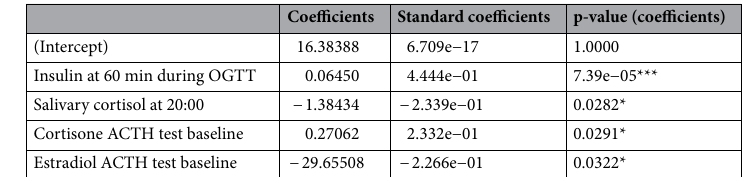
Table 1. Coefficients, standard coefficients and p-values of coefficients of each variable in the linear regression model. *p-value <0.05; ***p-value <